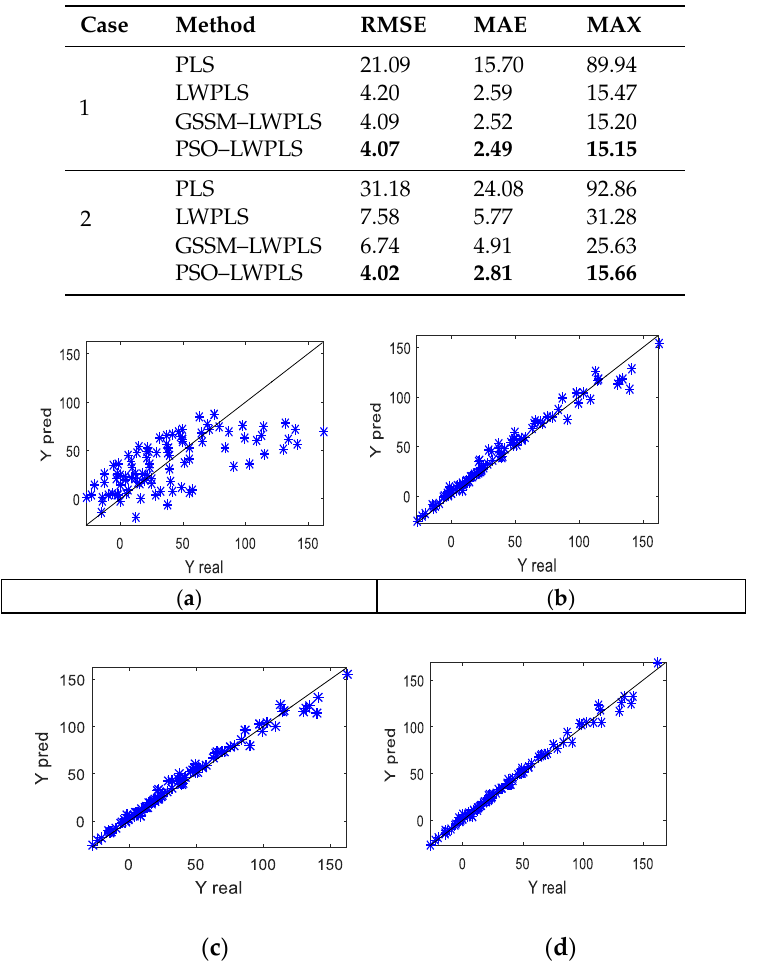
Figure 5. Comparison of scatter plots for the real and predicted Y values using four methods for case 2: ( a ) PLS; ( b ) LWPLS; ( c ) GSSM – LWPLS; and ( d ) PSO – LWPLS.